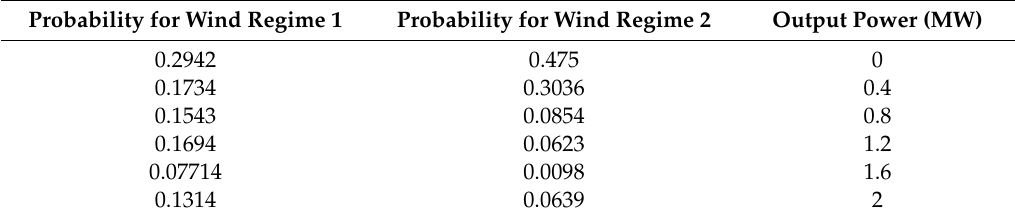
Table 6. Two-megawatt wind farm output power model for two wind regimes. Probability for Wind Regime